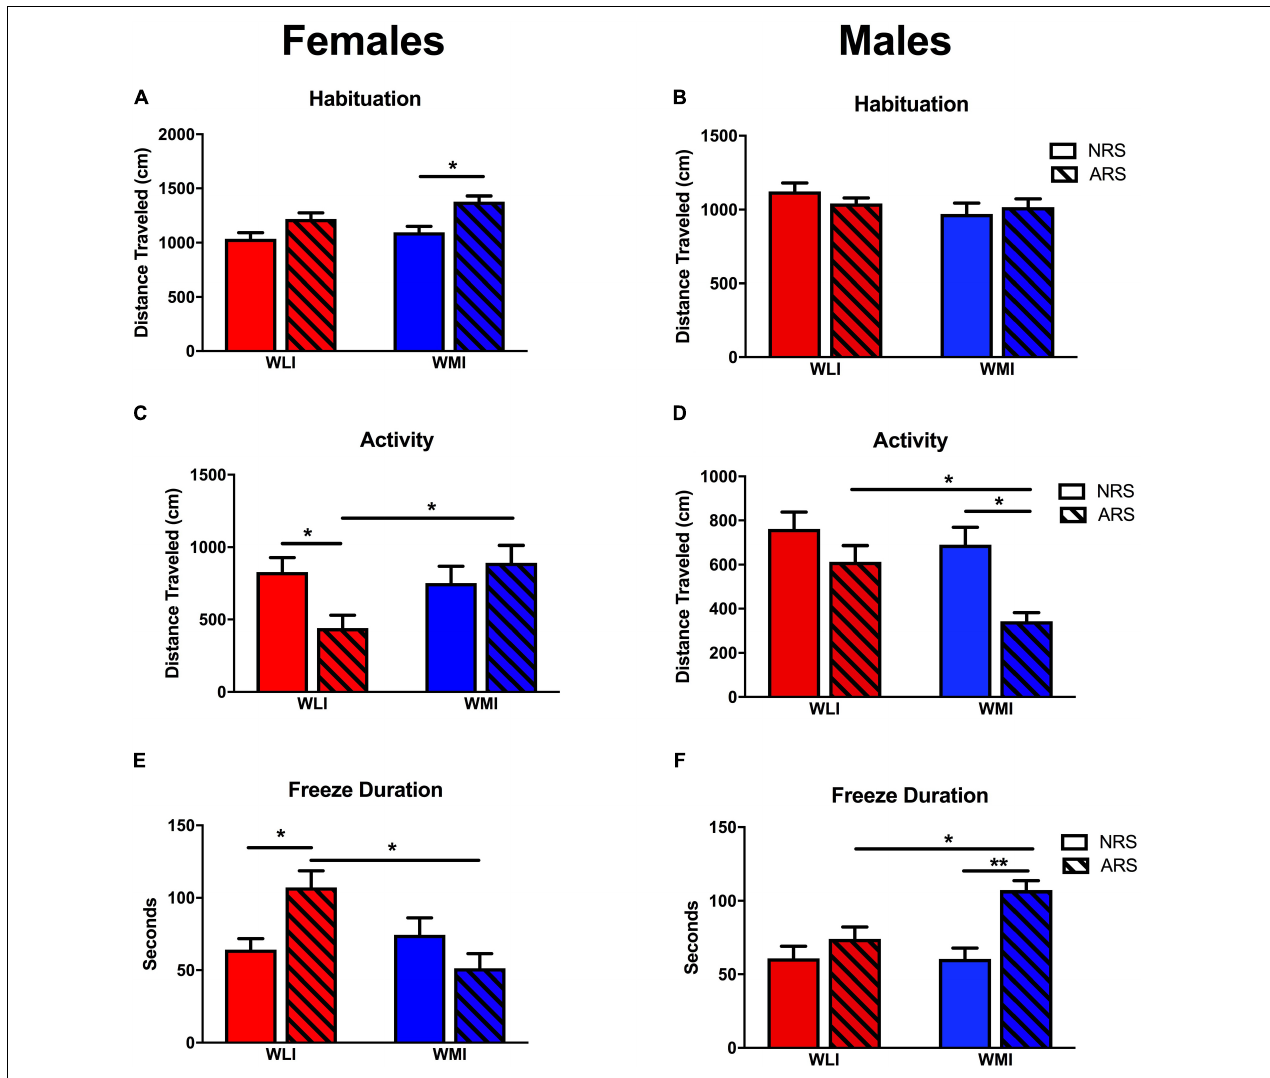
FIGURE 2 | Fear Memory in CFC. Pre-CFC activity, measured by distance traveled in females (A) and males (B) . Distance traveled prior to the conditioning stimulus did not differ significantly between strains or acute stress (ARS) and no-stress (NRS) conditions except for WMI females, which showed increased activity after acute restraint stress. Distance traveled on the second day of the contextual fear conditioning did not differ between NRS WLI and WMI females (C) or NRS males (D) . However, WLI females and WMI males showed significantly decreased distance traveled after ARS. Showing the inverse relationship, WLI females and WMI males showed significantly increased freeze duration after ARS, with no differences in fear duration between the strains in the NRS condition (E , F) . Values are shown as mean ± SEM; ∗ p < 0.05, ∗∗ p < 0.01, post-hoc following ANOVA. WLI NRS male n = 26; NRS female n = 23; AS male n = 17, AS female n = 13; WMI NRS male n = 15, NRS female n = 18, AS male n = 15, AS female n =